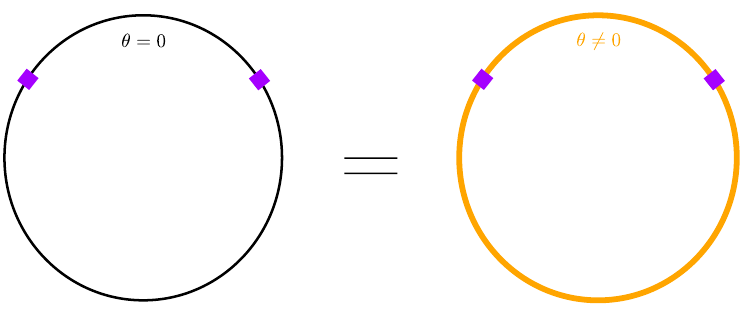
Figure 4 . The figure illustrates one of the main conditions imposed in our derivation, where the thick orange line represents the line with the deformation switched on ( θ 6 = 0 ), and the thin dark line represents the original 1D CFT with θ = 0 . The inserted operators are 1 with polarisation orthogonal to the plane of the θ -rotation. We demand that such 2-point function should be